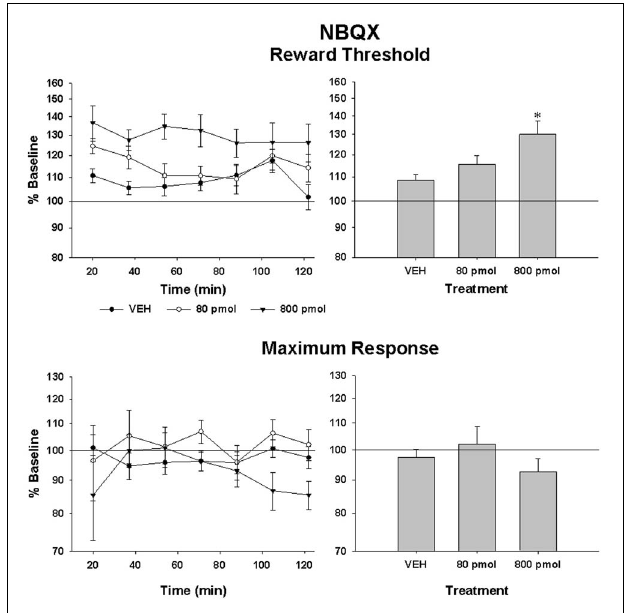
FIGURE 3 | Changes in reward threshold (top panels) and maximum response (bottom panels) as a function of time (left panels) after injection of vehicle (VEH) and each of the two doses of NBQX. Data represent the mean ( ± sem) from eight animals and are expressed as percentage of baseline on a log scale. Changes (mean ± sem) measured over the entire test session are shown in the right panels. Asterisk indicates a statistically significant difference ( p < 0 . 05) with VEH.